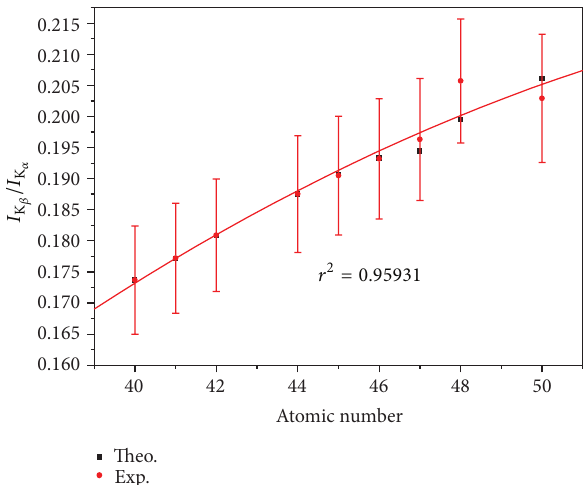
/𝐼 as a function of atomic number. K 𝛽 K 𝛼